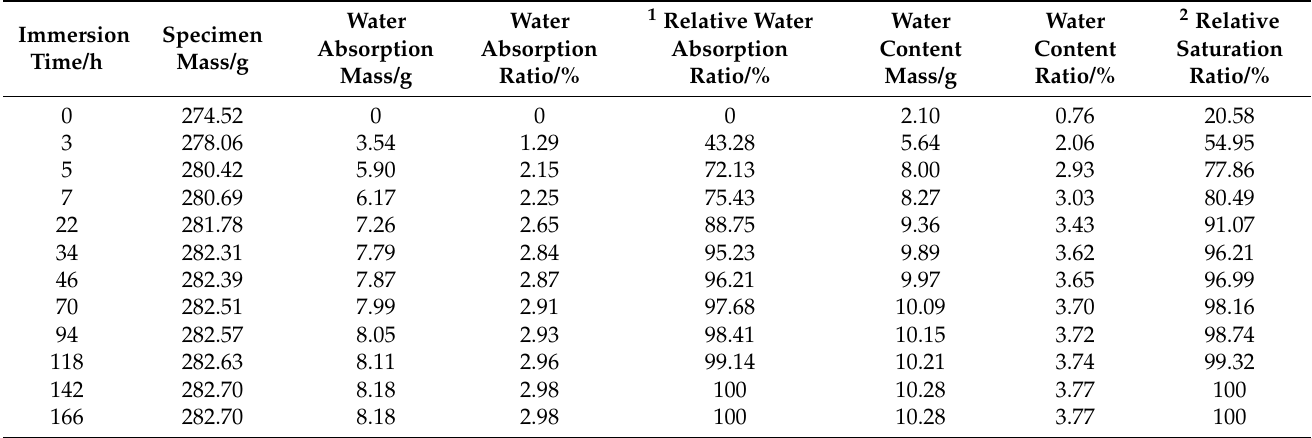
Table 4. Water absorption of the φ 70 mm × 35 mm concrete specimens immersed for different times and placed in a dry room at normal temperature for 9 months.